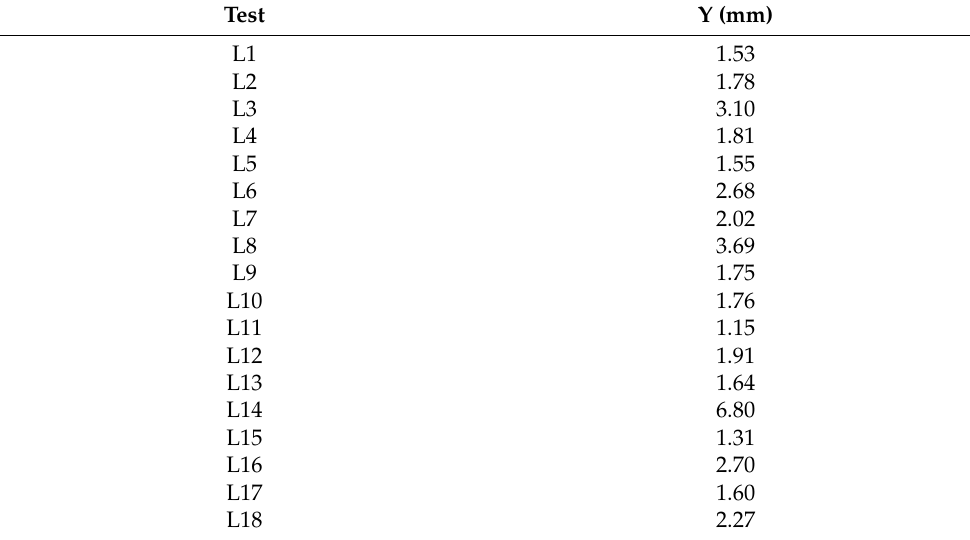
Table 3. Standard deviation response Y of the plan surface